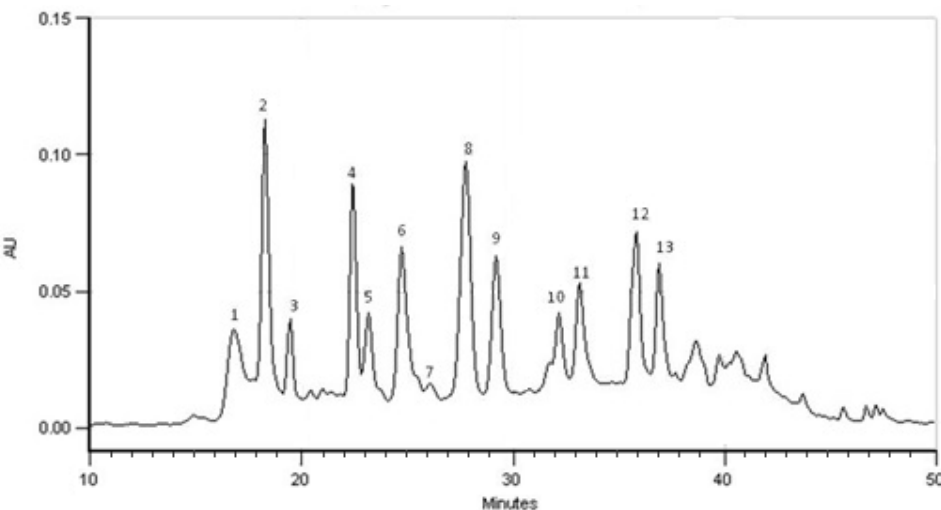
Figure 1. Chromatographic profile obtained from Cymbopogon citratus extract at 280 nm. Identification of the compounds is provided in Table 1. Table 1. Identification of phenolic compounds of Cymbopogon citratus extract (recorded at 280 nm).